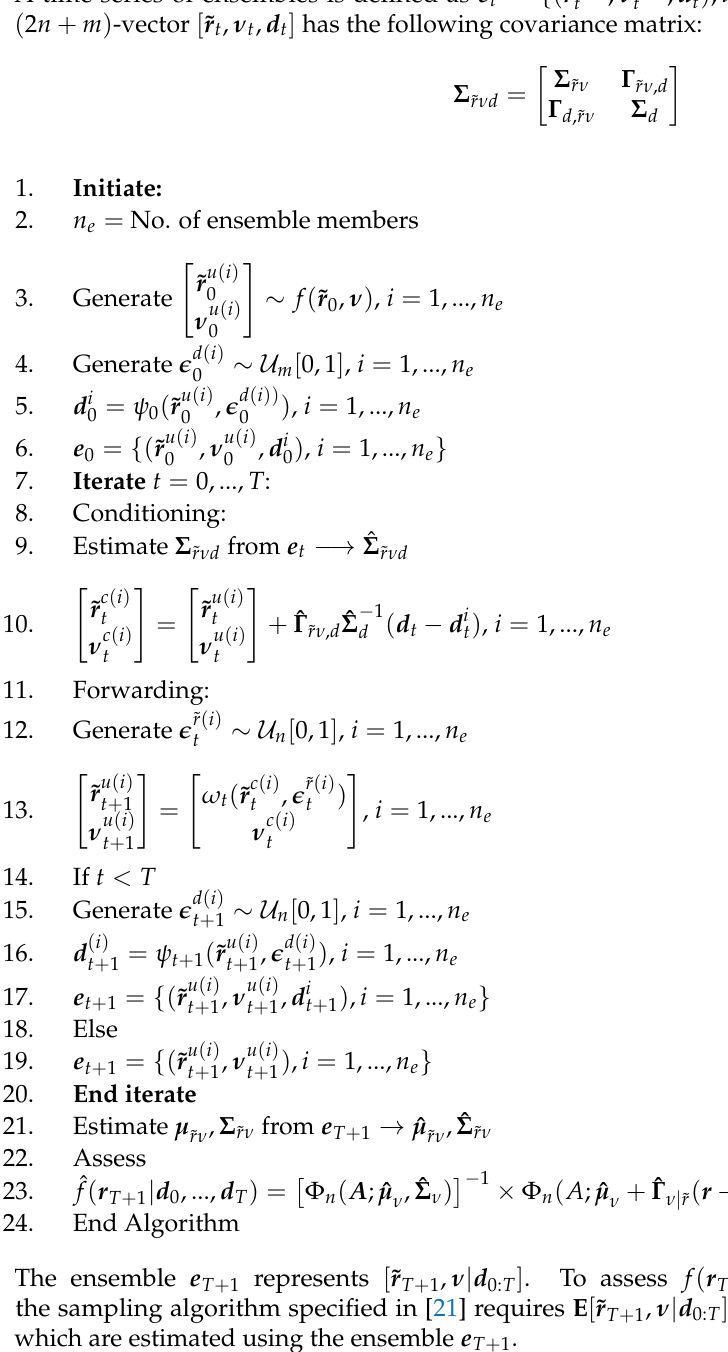
Algorithm A1 Selection Ensemble Kalman Filter